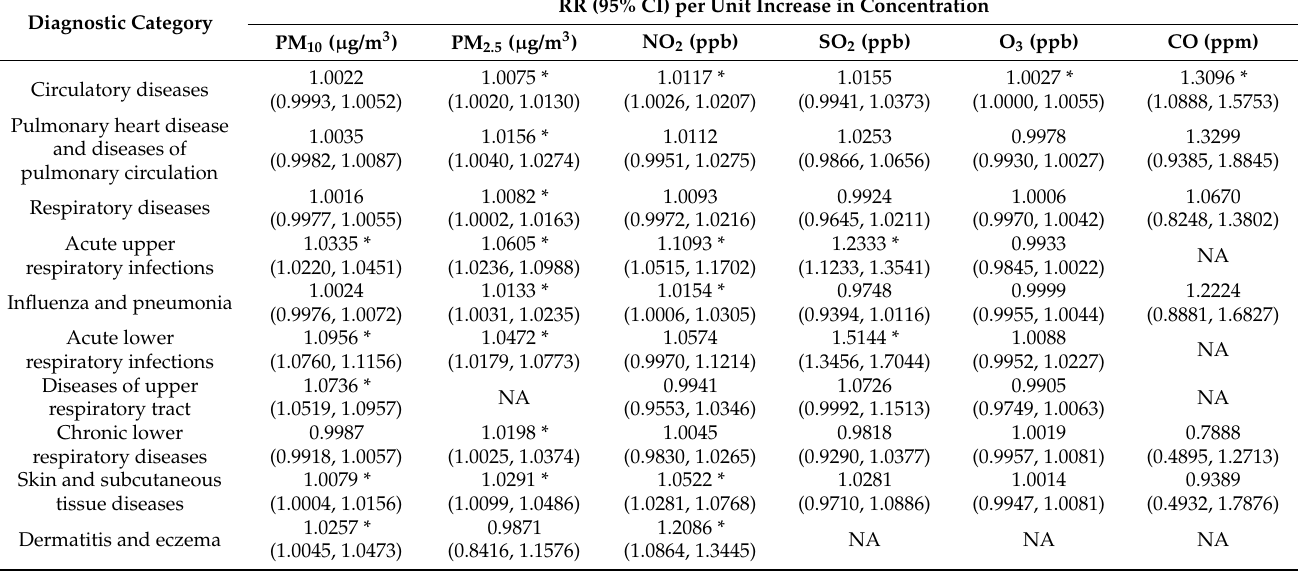
Table 5. Associations between unit increase in pollutant concentrations and mortality from spe- cific causes.